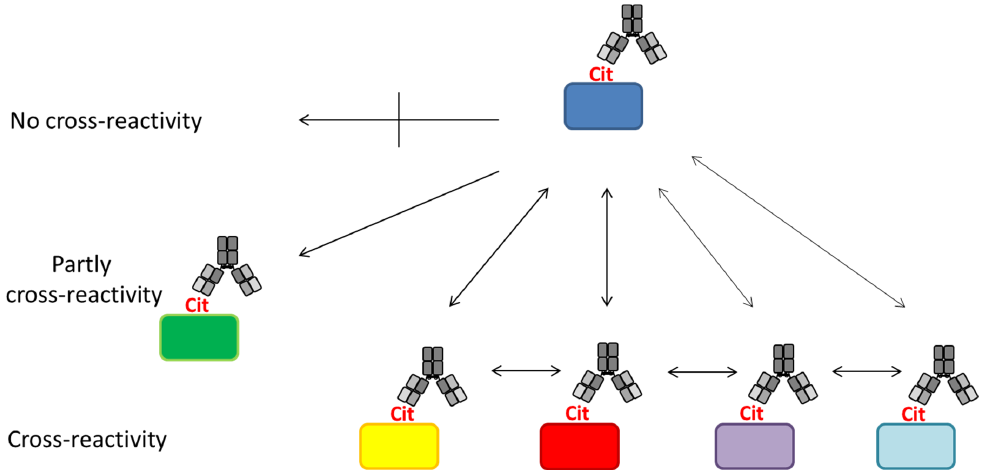
Figure 4. Anti ‐ citrullinated protein antibodies are a collection of partially cross ‐ reactive antibodies recognizing citrullinated targets. ACPA reactivities can be divided into several (partially) cross ‐ reactive fine specificities. Some ACPAs captured by a citrullinated protein cross ‐ react with other citrullinated proteins. A small group of ACPAs appears to have limited or no cross ‐ reactivities. Different colors indicate different proteins.